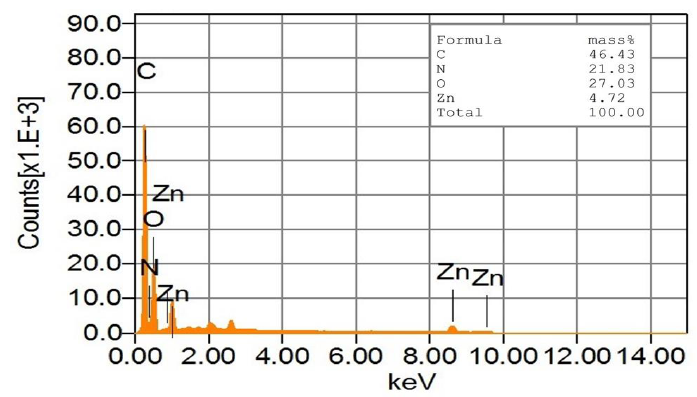
Figure 7. EDS spectrum of the 2Nph-BU-Cs/ZnONPs-5% composite with the percentage of its elements.